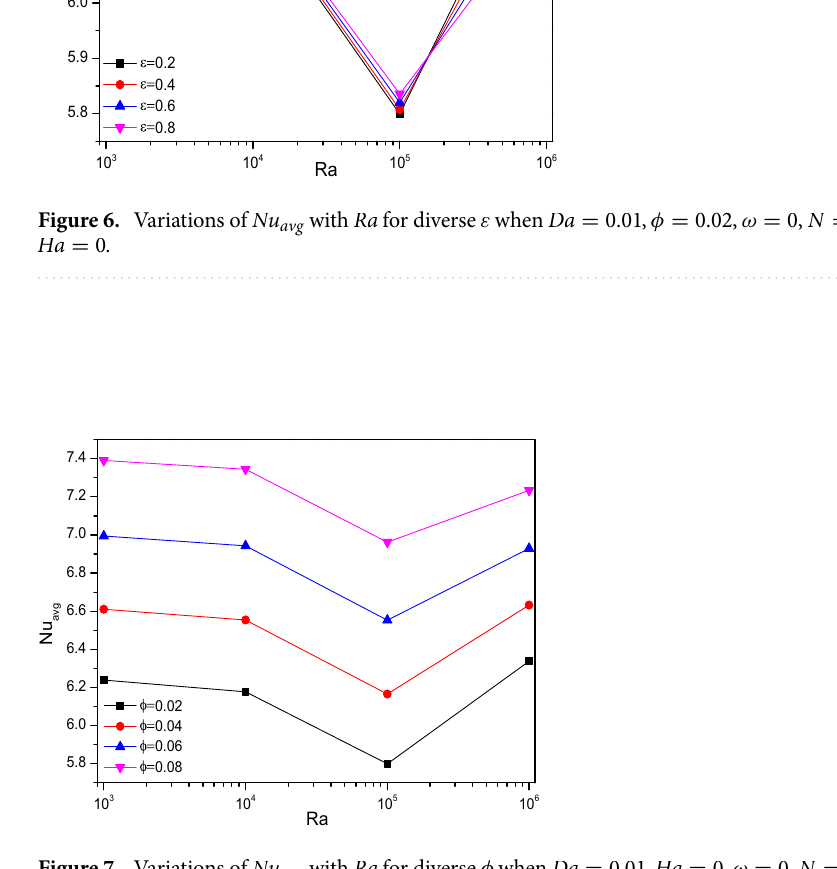
Figure 7. Variations of Nu avg with Ra for diverse φ when Da = 0.01 , Ha = 0 , ω = 0 , N = 4 , r = 0.1, and ε = 0.2